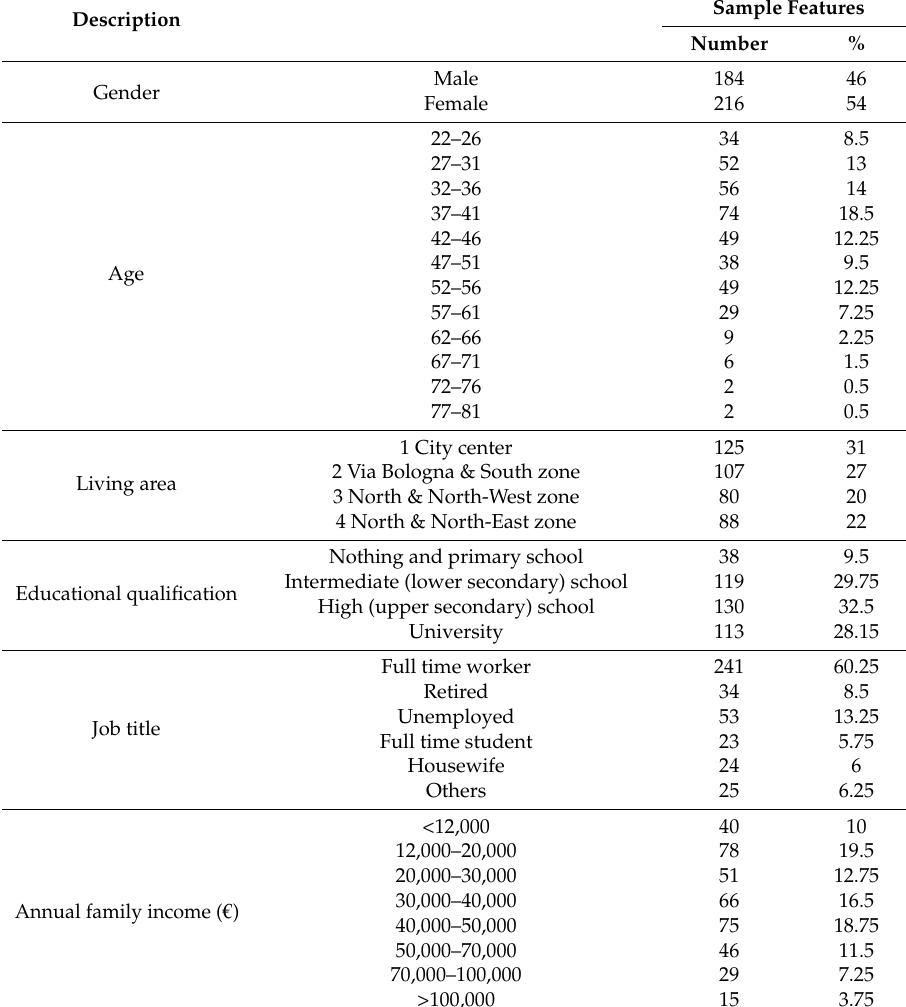
Table 3. Socio-demographic and economic characteristics of the